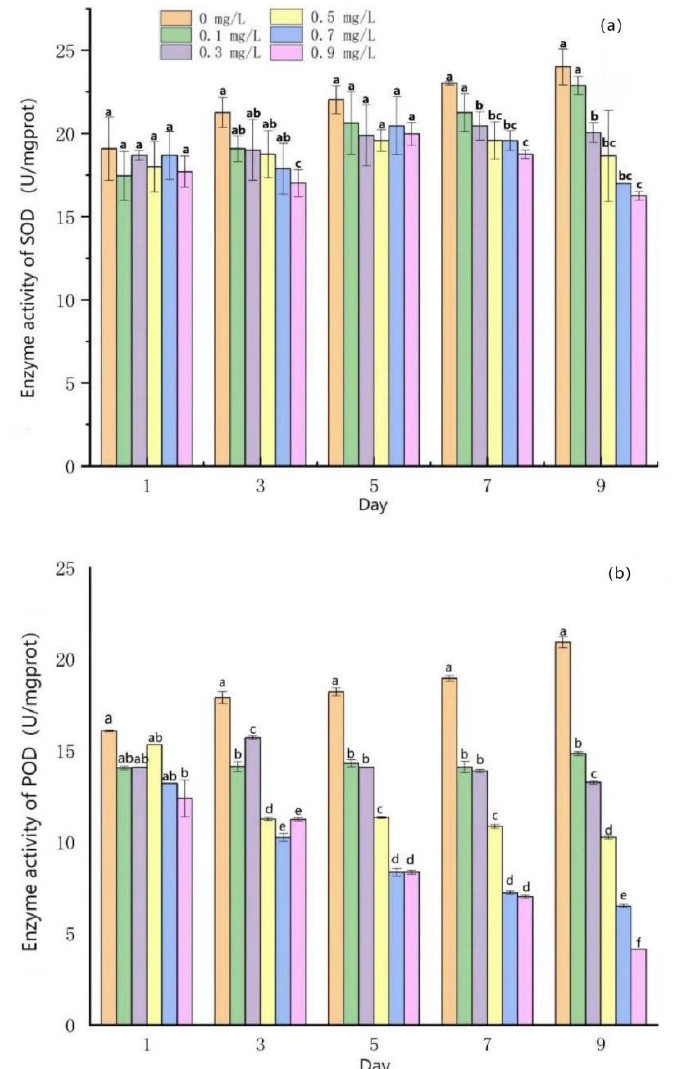
Figure 4. Effects of mercuric chloride concentration on antioxidant enzyme activities of Scenedesmus quadricauda : ( a ) enzyme activity of SOD; ( b ) enzyme activity of POD (N = 3, the calculated value is the standard deviation). Note: The data in the above figures were analyzed using Duncan’s statistical method ( p < 0.05), and the letters indicate significant differences among different concentrations within a single time point. The same applies to the following graphs.